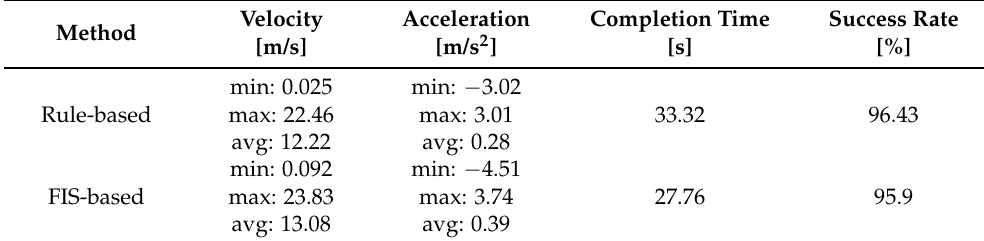
Table 4. Navigation system